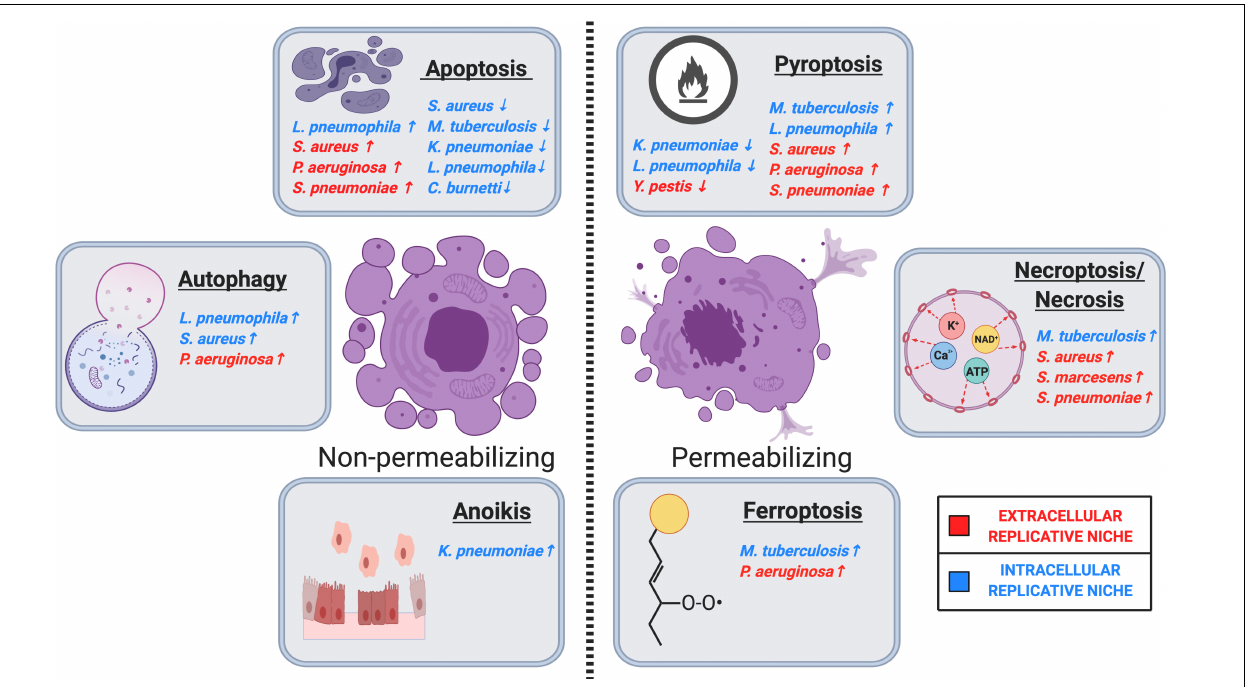
FIGURE 1 | Regulated cell death in host-pulmonary bacterial interactions. Major cell death pathways are shown in the figure according to their membrane permeabilization status. Pulmonary bacteria induce or inhibit host cell death through several distinct modalities, including apoptosis, autophagy, anoikis, ferroptosis, necrosis/necroptosis, and pyroptosis. ↑ Indicates that the bacteria induces the indicated cell death pathway, while ↓ indicates that the bacteria inhibits the indicated cell death pathway. Intracellular or extracellular bacteria are labeled according to the legend. Image created with